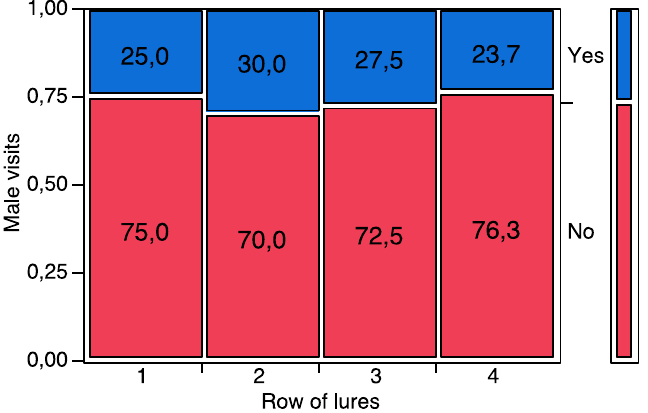
Figure 3. Contingency analysis between the rows of pheromone-baited lures (1 µ g per lure, 16 lures, four per row across the wind) tested in the flight tunnel and the visits received by P. calceolariae males. The bar on the right represents the relative abundance (%) of male visits to a given row of lures over the total number of tested individuals. The number within each box shows the percentage of males visiting a given row of pheromone-baited lures. Yes = the male visited a given row of lures. No = the male did not visit a given row of lures. No significant di ff erences were found among male visits to the di ff erent row of lures ( p > 0.05).